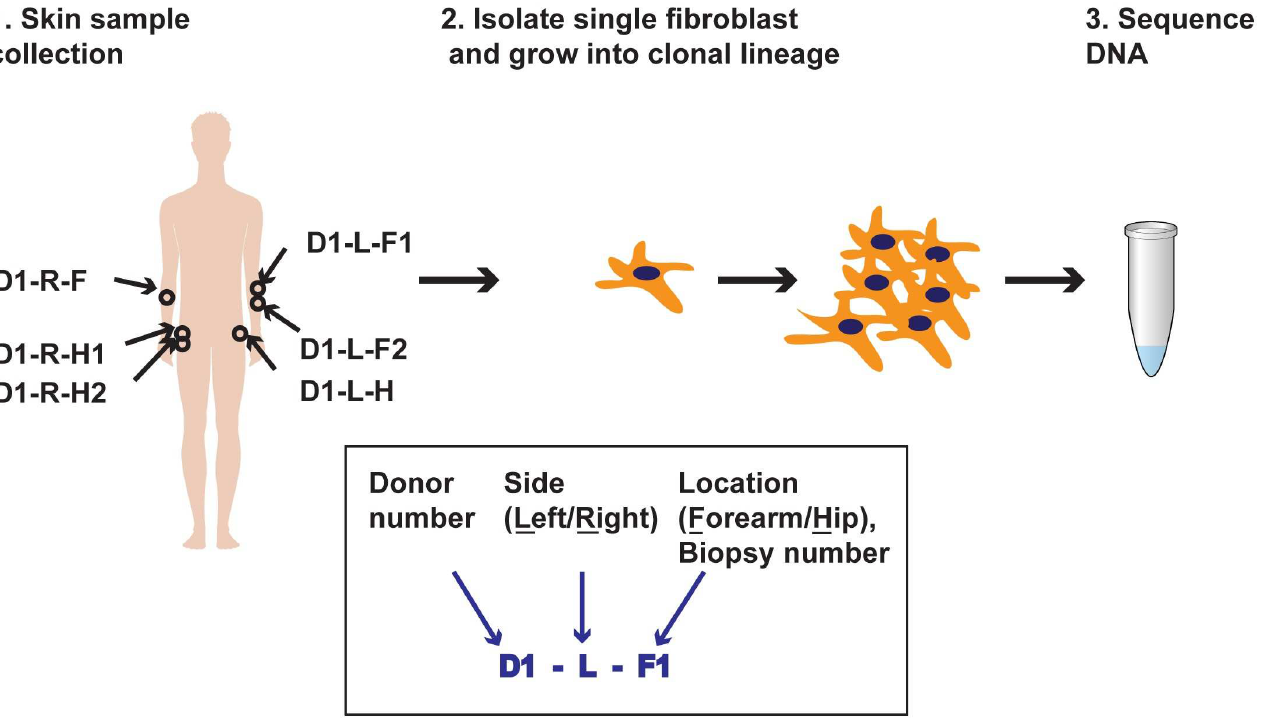
Fig 1. Schematic for isolation and sequencing of single-cell fibroblast clonal lineages. Example of Donor 1 is shown. Boxed insert illustrates the design of the clone IDs. Biopsy number is indicatedif adjacent biopsies were taken from the same site.